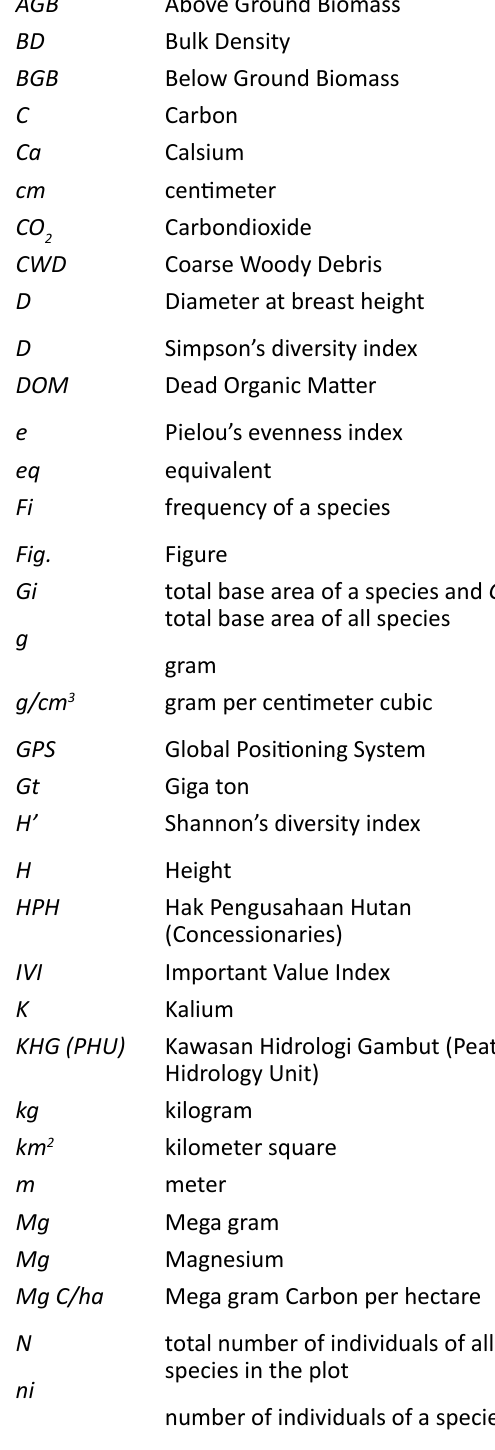
frequency of a species Figure total base area of a species and G is total base area of all